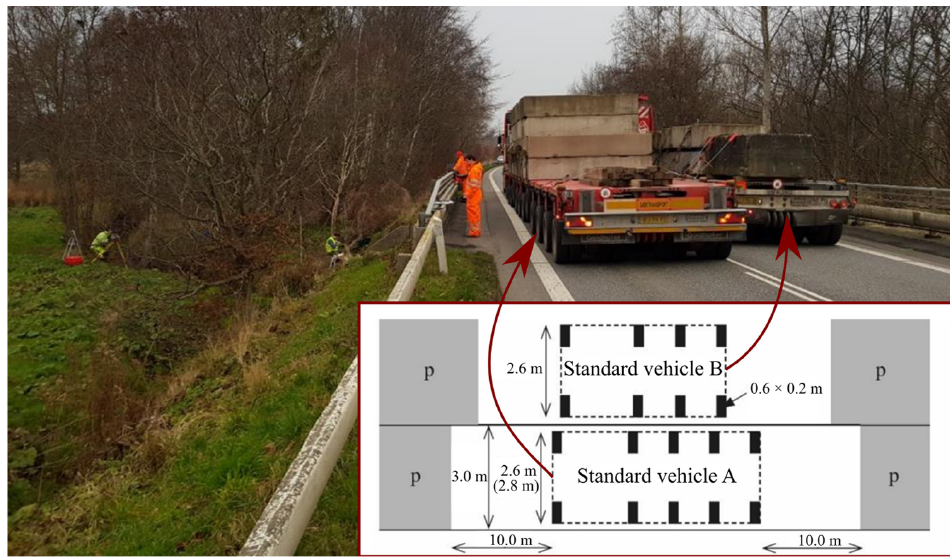
Figure 3. Trucks were used to apply accurate loading in accordance with the Danish classi fi cation system [21].